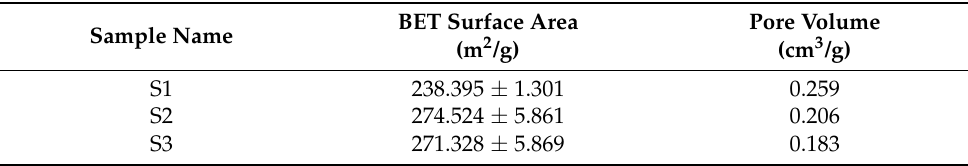
Table 5. Brunauer–Emmett–Teller (BET)